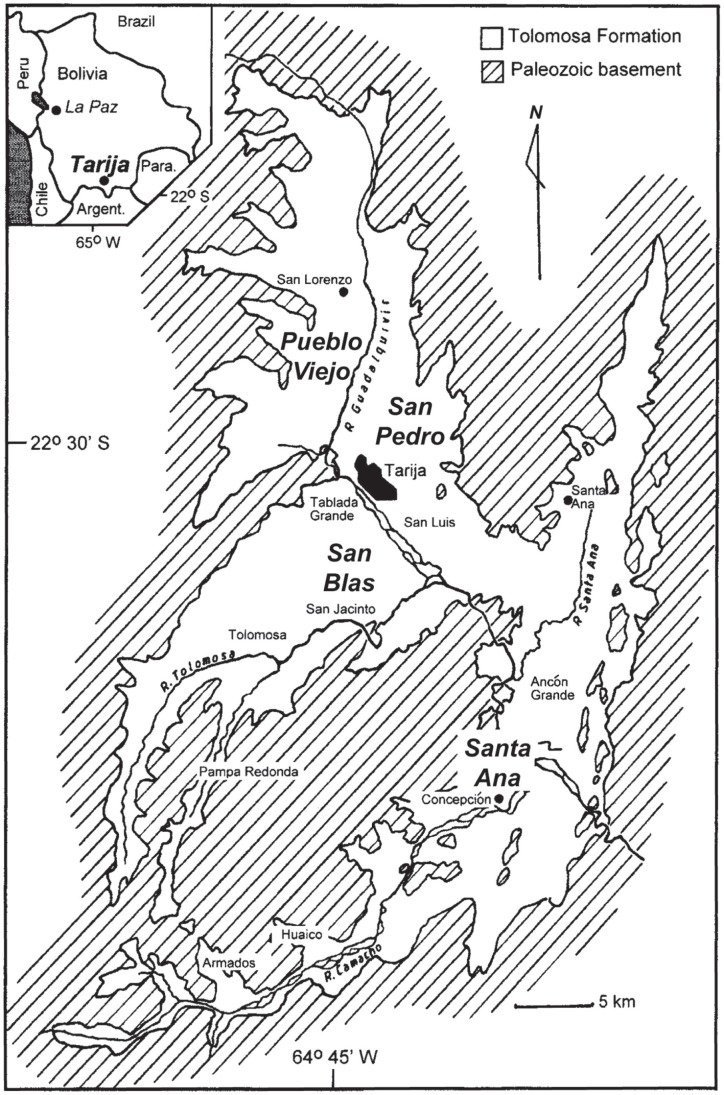
Geographic location of Tarija, Bolivia.Map locating Tarija (insert, upper left) in southern Bolivia and distribution of outcrops of the Tolomosa Formation surrounding the city of Tarija, with the location of the four measured sections discussed in this paper [8], [10], [24]. Also see correspondence with Figure 3.